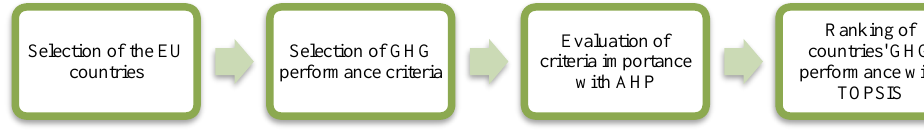
Fig. 2. Methodology